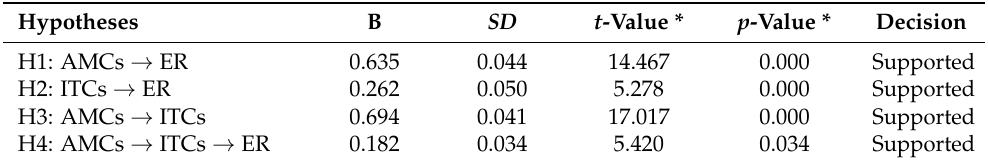
Table 3. Hypotheses